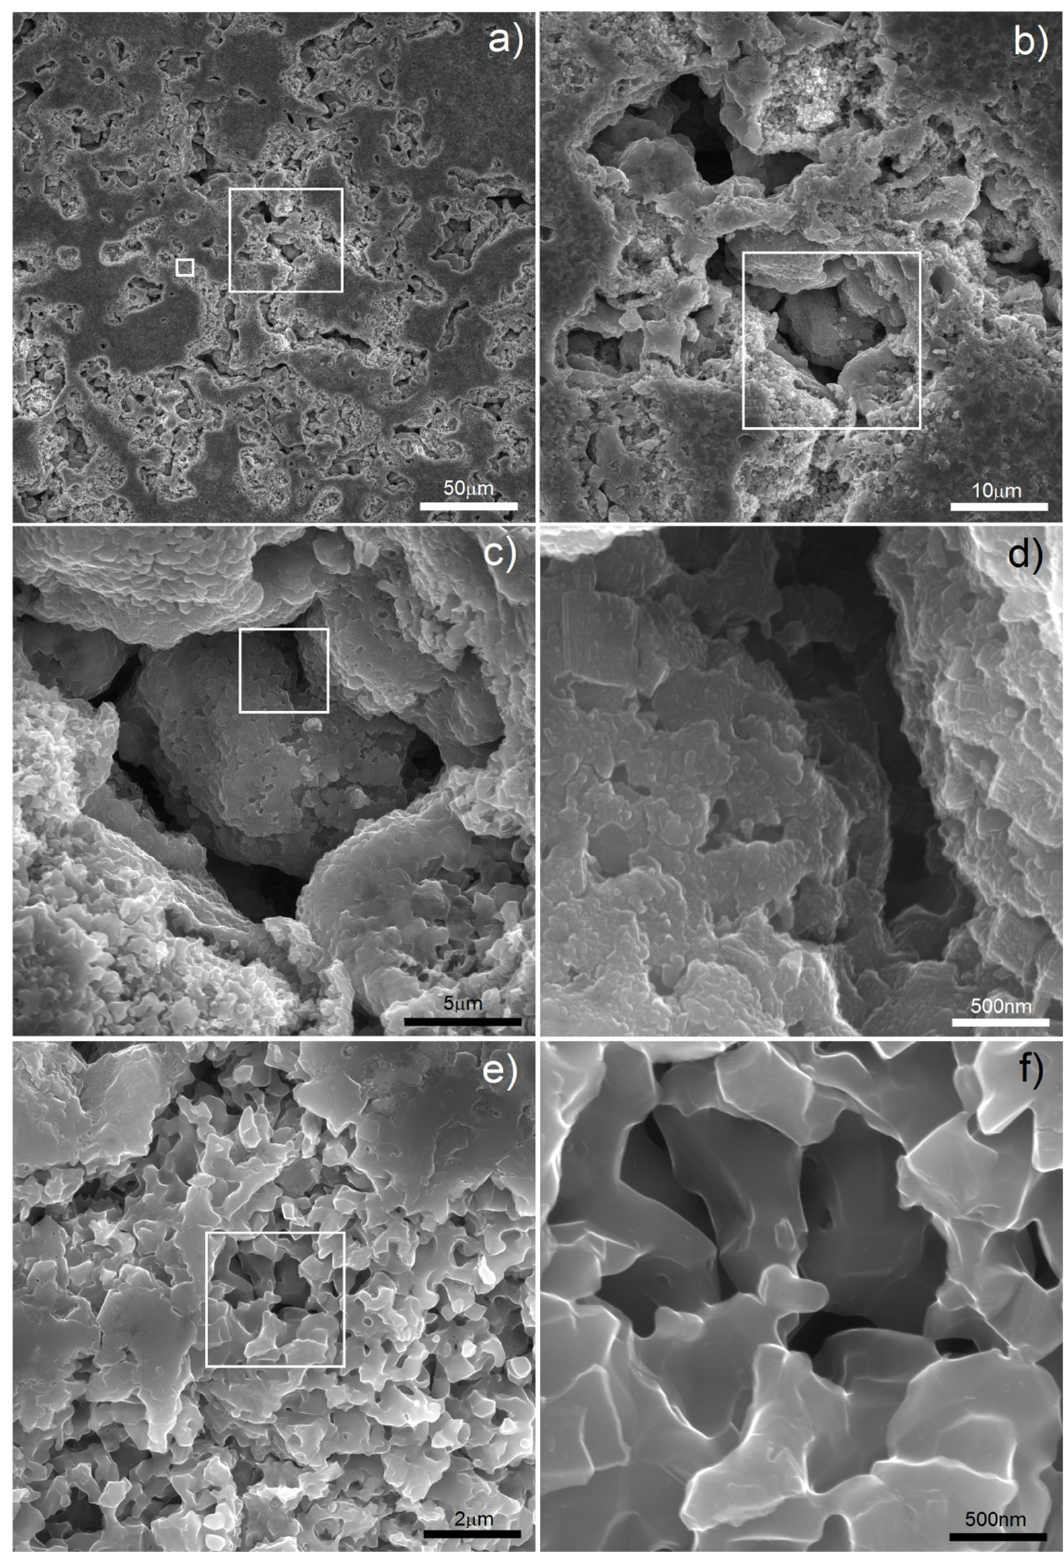
Figure 3. SEM micrographs of Ti20Nb5Zr foam after dealloying: ( a – d ) various magnifications of larger pores; ( e , f ) various magnifications of smaller pores.